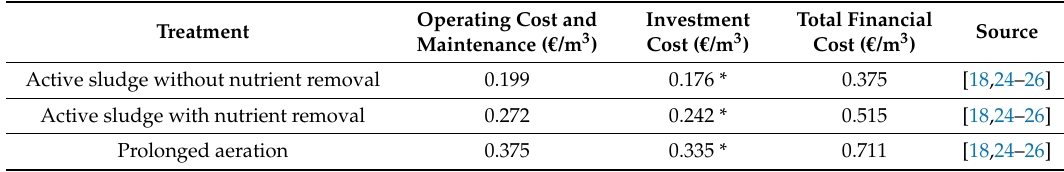
Table 2. Table 2. Costs of secondary treatments updated to